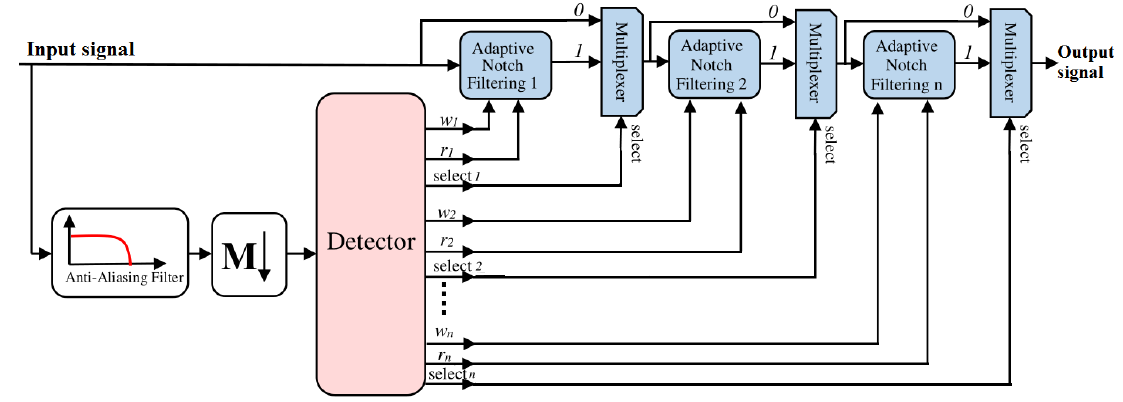
Figure 2. General block diagram of the proposed detector.